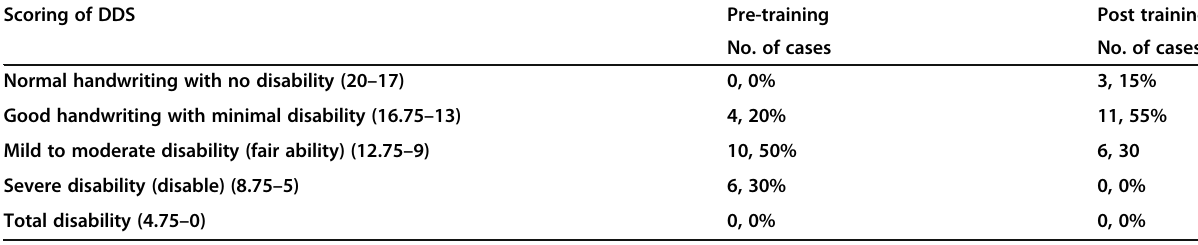
Table 1 Frequency percentage distribution of dysgraphia disability scale ( N , 20 cases) Scoring of